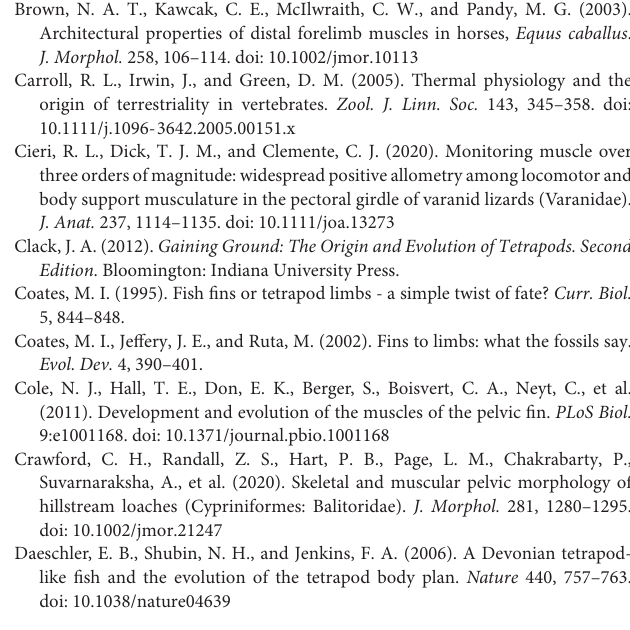
Supplementary Table 1 | Hypotheses of homology between pectoral appendicular muscles of fishes and tetrapods used in this manuscript, based on Diogo et al. (2016). Supplementary Table 2 | Hypotheses of homology between pelvic appendicular muscles of fishes and tetrapods used in this manuscript, based on Diogo et al.